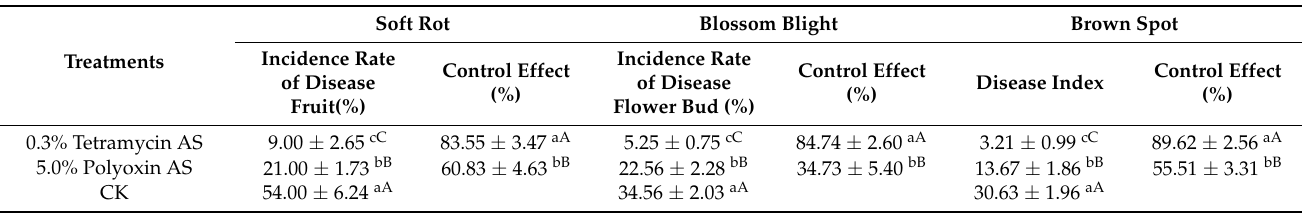
Table 3. The control effects of tetramycin and polyoxin on soft rot, blossom blight and brown spot diseases of kiwifruit.